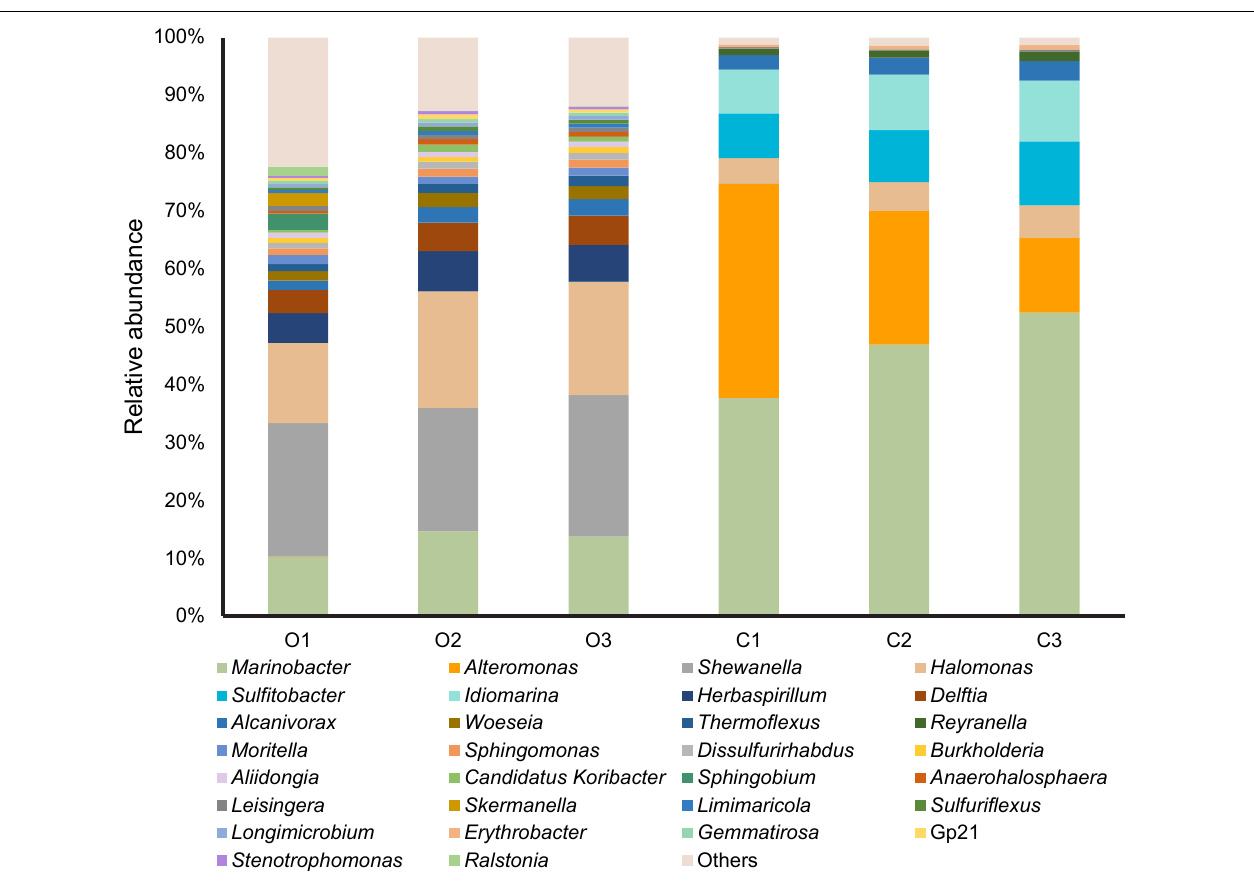
FIGURE 2 | Genus-level taxonomic structure of the original and cultured sediment samples. The top 30 abundant genera in terms of maximum relative abundance are shown. C1–3 represent the three cultured samples, and O1–3 represent the three original samples without laboratory cultivation.